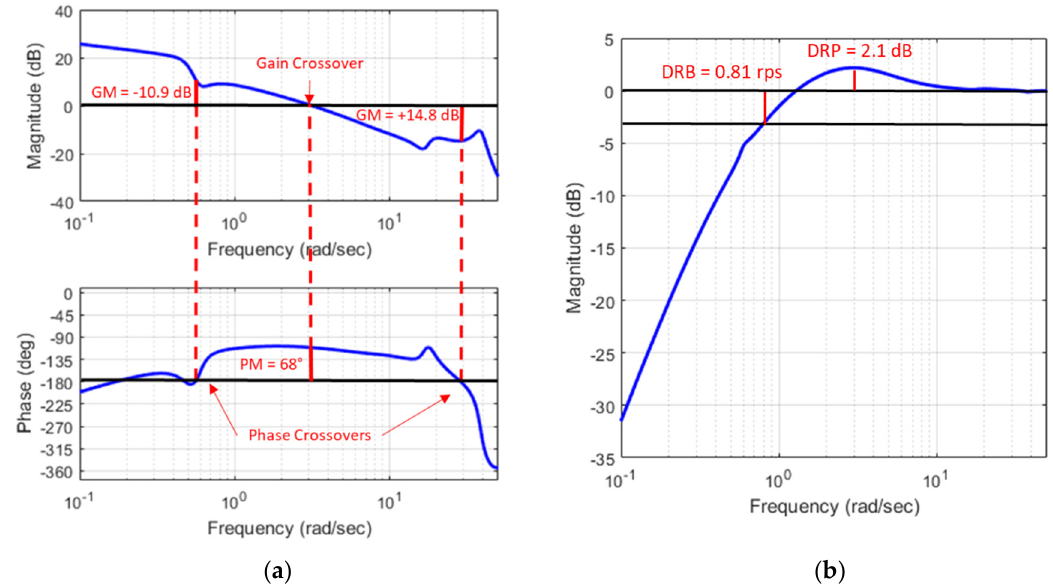
Figure 11. Sample SM and DRB analysis curves: ( a ) Broken loop frequency response for pitch axis for gain and phase margin analysis; ( b ) Sensitivity function of the pitch attitude feedback used for DRB analysis.